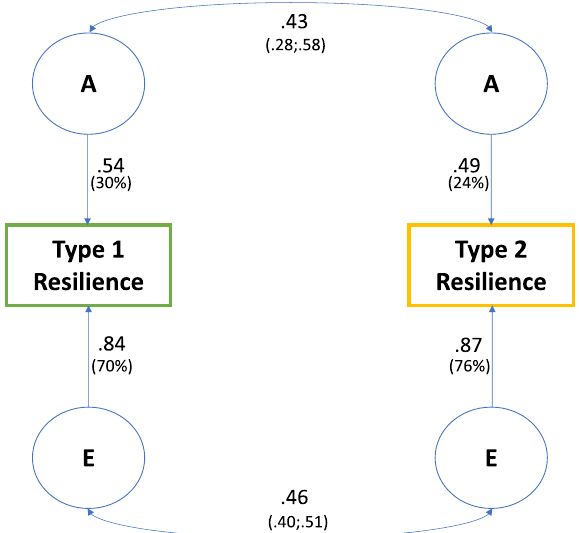
Figure 1. Results from the best fitting bivariate model. “A” indicates the latent additive genetic factors and “E” represents individual-specific environmental factors. The magnitude of each path is shown in the figure, including the percent of the variance in the observed variable accounted for by the latent